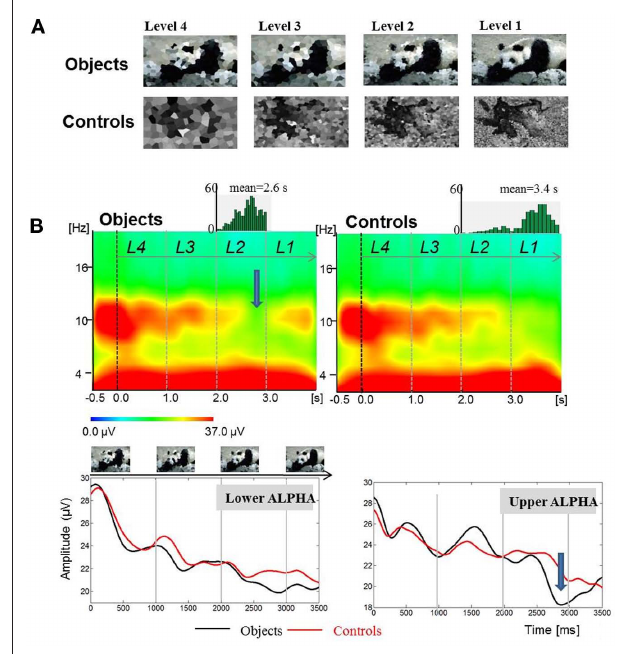
Figure 2 | Findings from an object recognition task show that the onset of erD is not related to the onset of stimulation. Data are from Freunberger et al. (2008b). (A) Example of stimuli (upper panel). (B) A large ERD (indicated by an arrow) develops during the time window, in which an object is recognized. The upper panel shows time–frequency power plots for object- and control-items. The lower panel shows absolute power values for the lower and upper alpha band (Reprinted